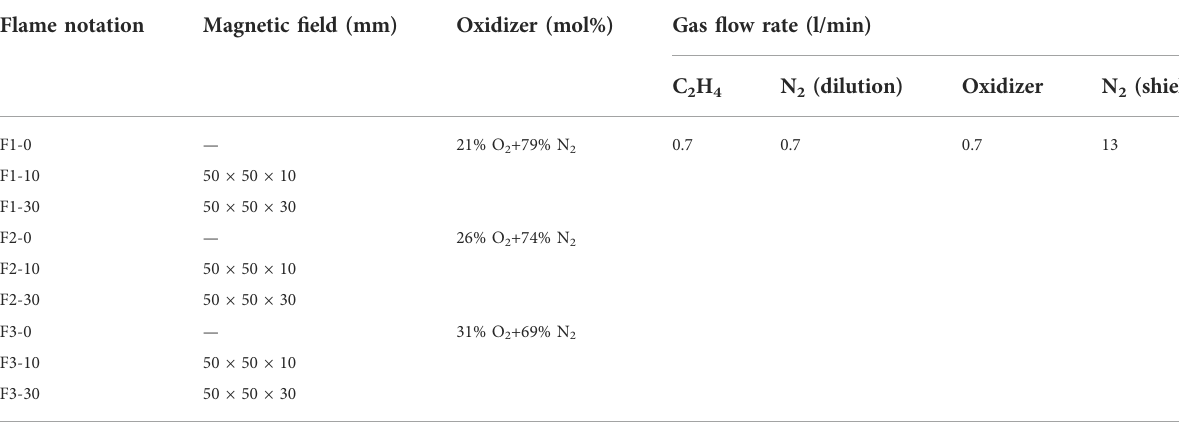
TABLE 1 The detailed fl ame conditions.